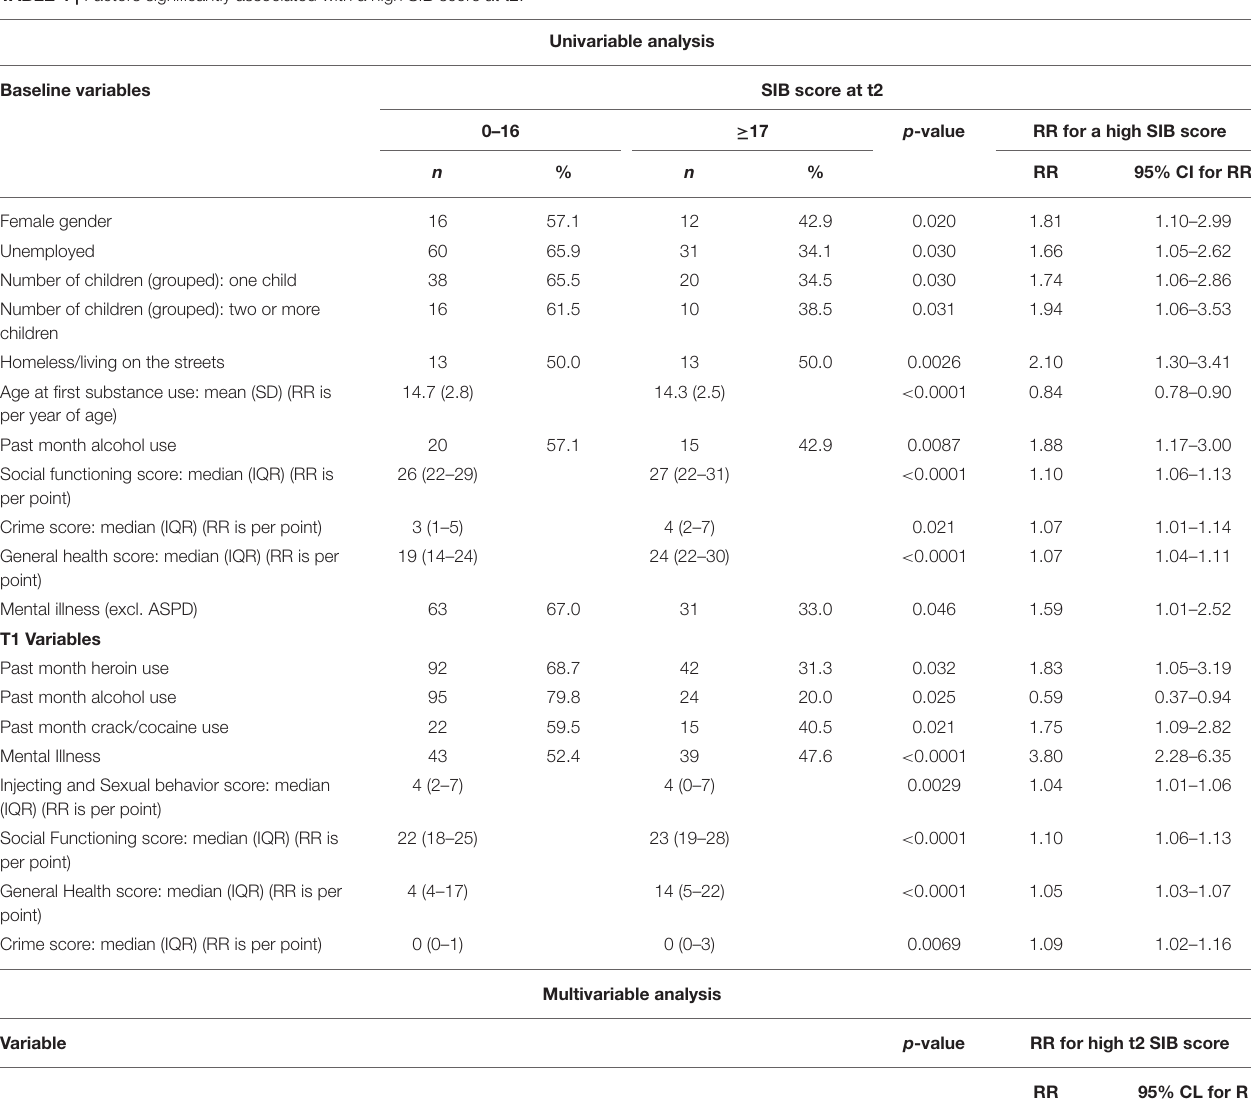
TABLE 4 | Factors significantly associated with a high SIB score at